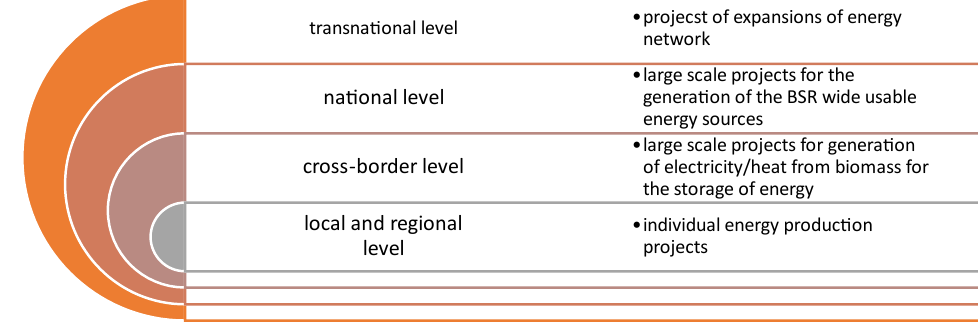
Figure 21. Cooperation level and energy transition projects. Source: own study based on [90].